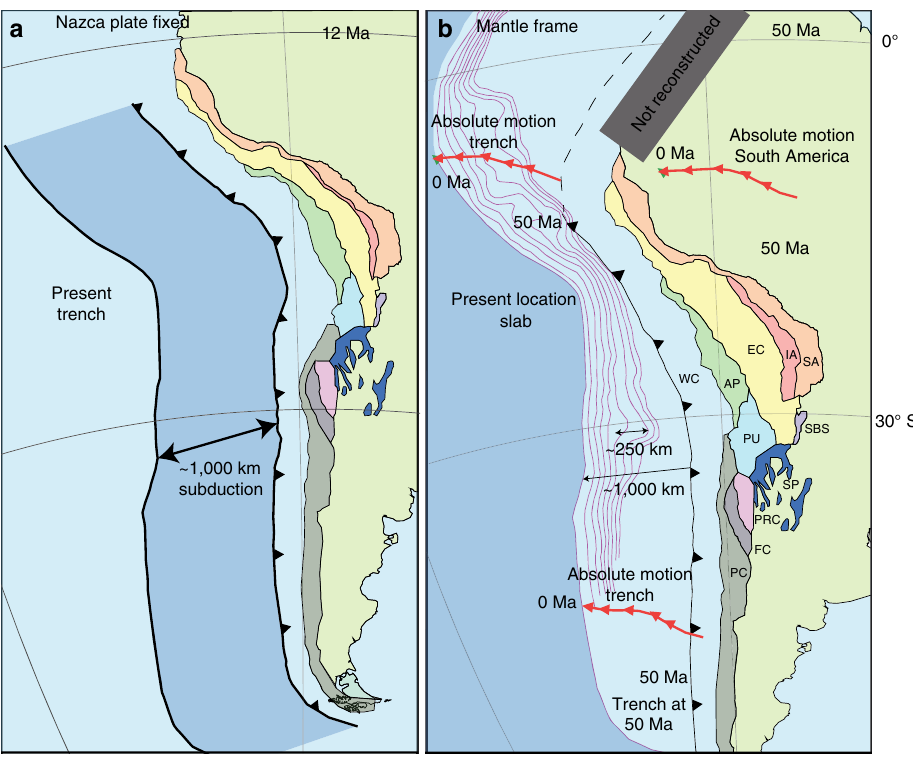
Figure 5 | Reconstructions of the central and Southern Andean fold-and-thrust belt. ( a ) Reconstruction of the Central and Southern Andean fold-and- thrust belt at 12Ma with a fixed Nazca Plate colours of the deforming geomorphologic regions are the same as in Fig. 1. The distance between the present trench and the trench at 12Ma equals the amount of subduction of the Nazca Plate underneath the South American Plate since 12Ma, shown here in darker blue. ( b ) Reconstruction of the Central and Southern Andean fold-and-thrust belt at 50Ma in a hotspot mantle reference frame 25 , colours of the deforming geomorphologic regions are the same as in Fig. 1. The purple lines represent the present depth contour lines of the Nazca Plate from 0 to 160km with a 20km interval 6 . The amount of slab rollback for a dipping slab perpendicular to the present depth contour lines is B 1,000–1,100km, for the flat slab segment this is B 250km less. The arrow lines represent the motion paths 25 of one point on the trench and the South American Plate since 50Ma to its present position in steps of 5Myr. WC, Western Cordillera; AP, Altiplano Plateau; EC, Eastern Cordillera; IA, Interandes; SA, Subandes; PU, Puna Plateau; SBS, Santa Barbara System; PC, Principal Cordillera; FC, Frontal Cordillera; PRC, Precordillera; SP, Sierras Pampeanas; PAC, Patagonian